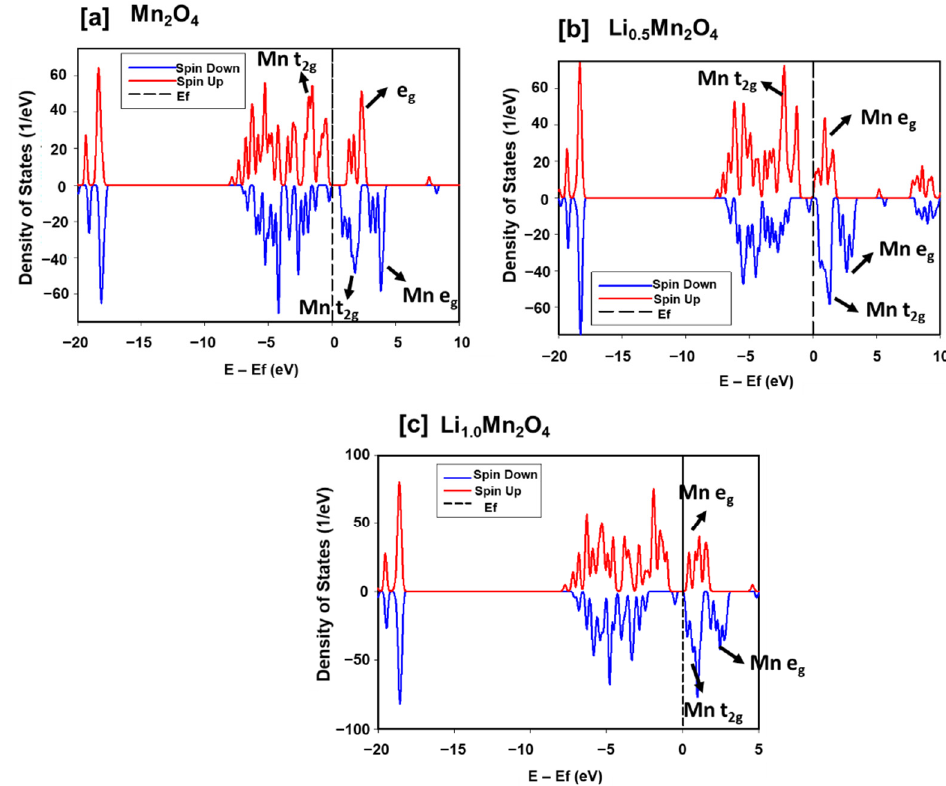
Figure 8. Spin up and spin down DoS of ( a ) Mn 2 O 4 , ( b ) Li 0.5 Mn 2 O 4 and ( c ) Li 1.0 Mn 2 O 4 calculated using ONETEP (Order-N Electronic Total Energy Package).